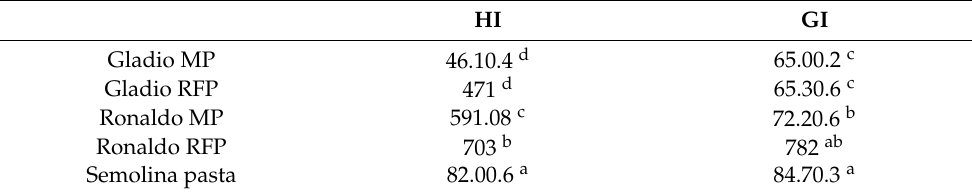
Table 3. Hydrolysis and predicted glycemic index of rice and semolina pasta.